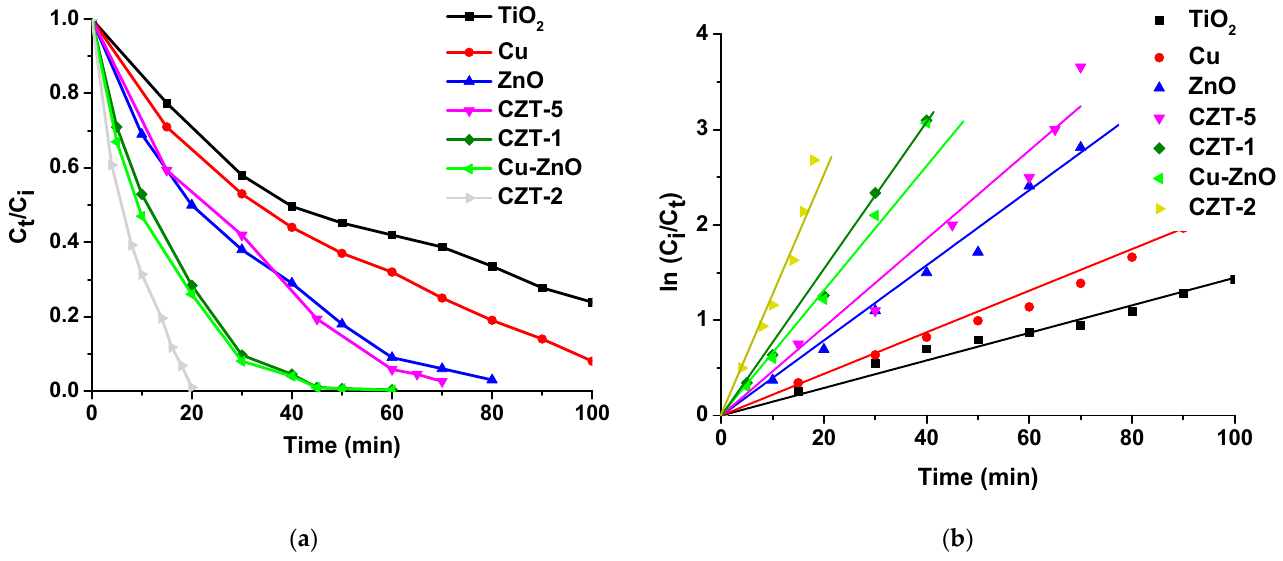
Figure 7. ( a ) Photocatalytic degradation of CR with different catalysts ( b ) The kinetic plot of CR degradation between ln (C i /C t ) and time (t) (reaction conditions: CR dye = 75 mg/L, catalyst loading = 0.5 g/L, sunlight irradiation = 20 min).